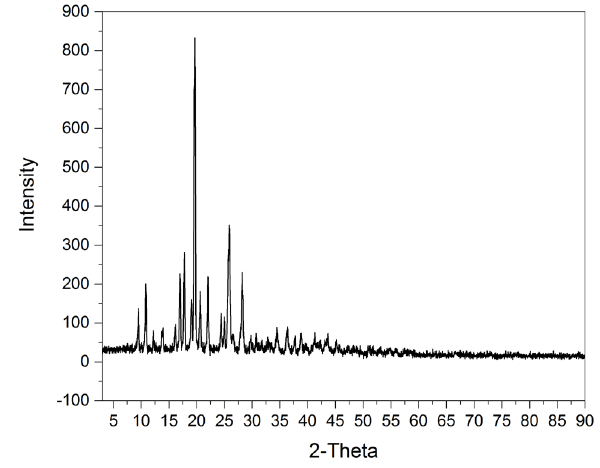
Figure 1: X-ray diffraction pattern of